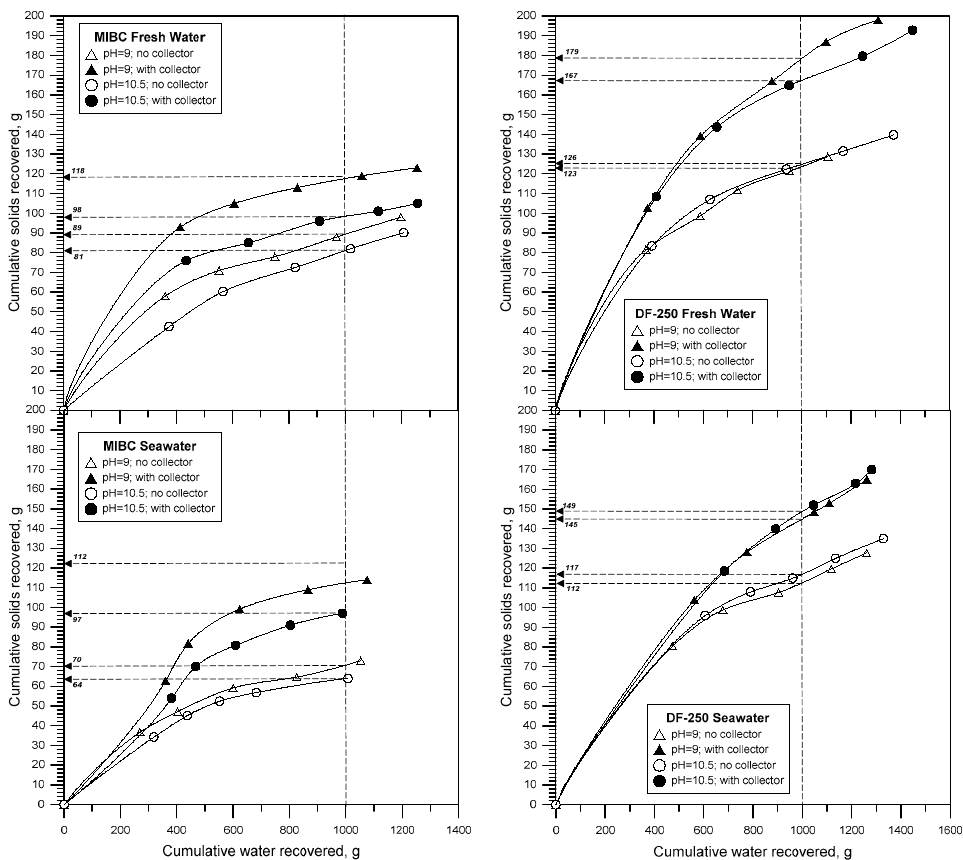
Figure 2. Cumulative solids recovered vs cumulative water recovered ( ε W ) using methyl isobutyl carbinol (MIBC) and DF-250, with and without collector ( Method 1 ).